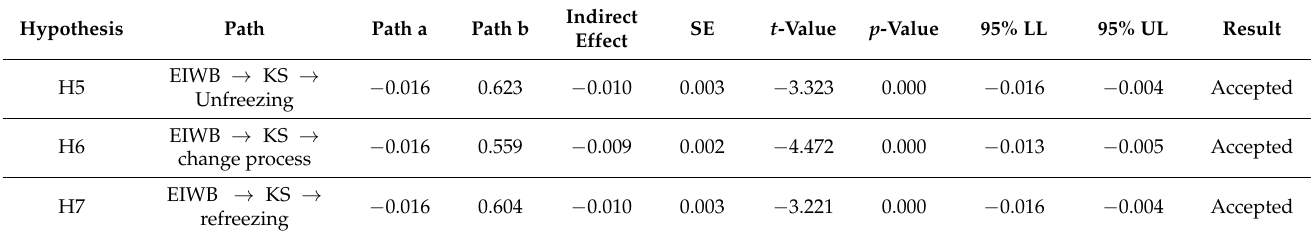
Table 6. Mediation